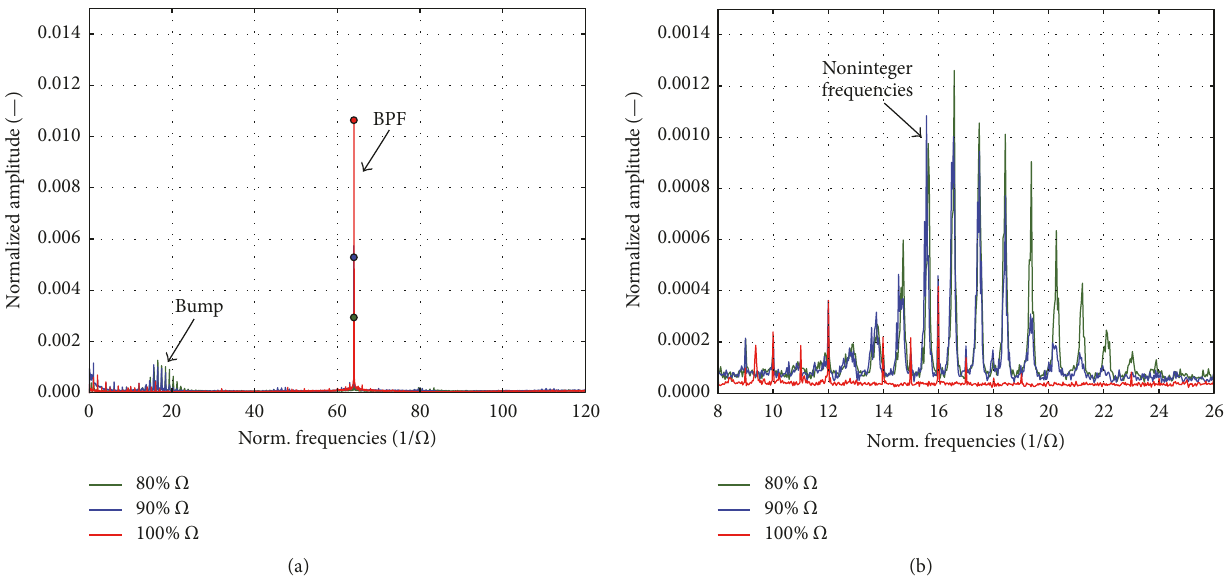
Figure 6: Frequency spectra of a casing pressure probe close to the rotor ∼ 1 LE in comparison of three shaft rotation speeds (80% Ω , 90% Ω , and 100% Ω ), “full” spectrum (a), and zoom on frequency bump (b).